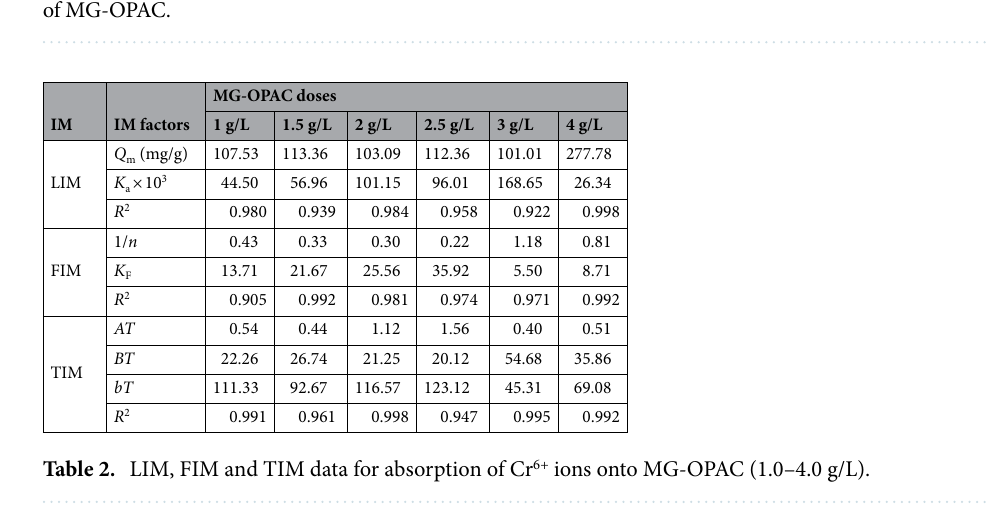
Figure 10. ( a ) LIM; ( b ) FIM for removal of Cr 6+ ions; ( c ) TIM adsorption of Cr 6+ over 1, 1.5, 2, 2.5, 3 and 4 g/L of MG-OPAC.